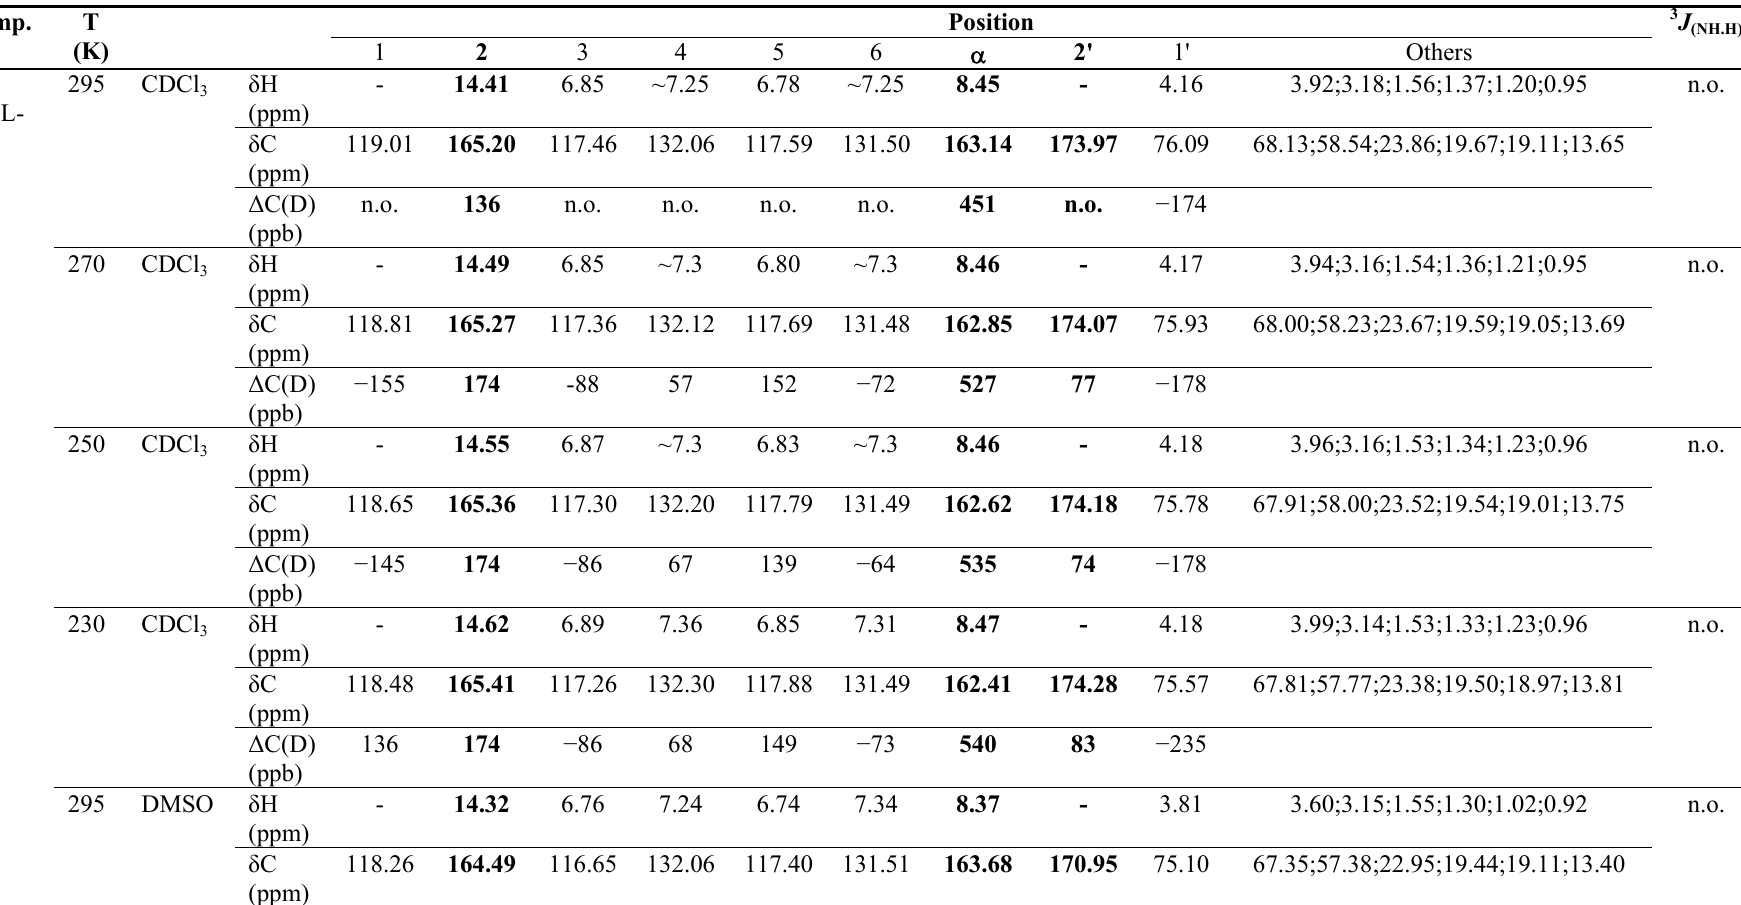
Table 1. 1 H and 13 C chemical shifts (ppm), deuterium isotope effects (ppb) and 3 J and DMSO.